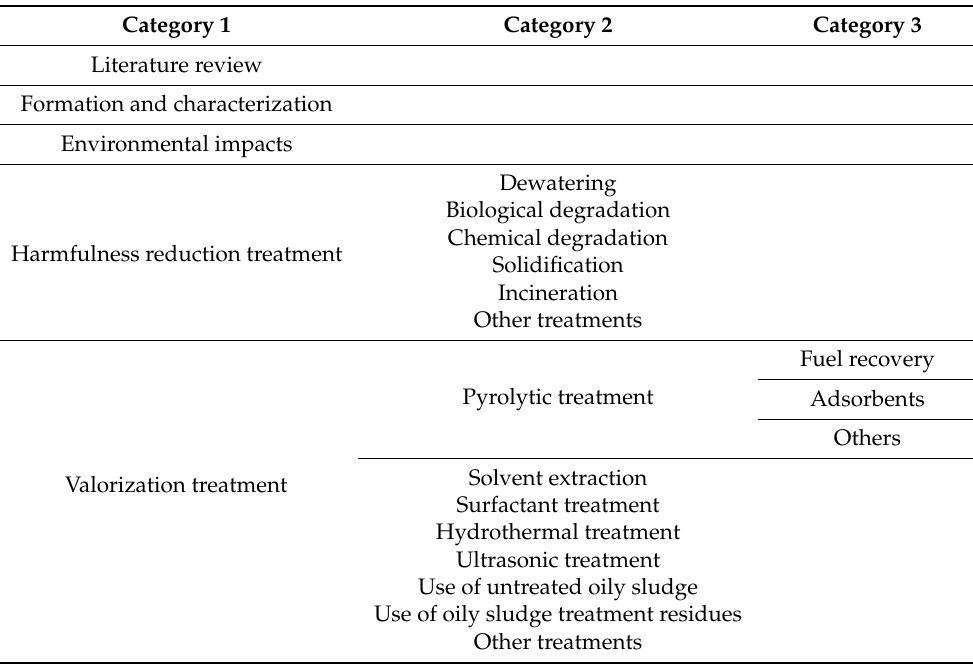
Table 4. The classification system of the oily sludge-related journal articles was retrieved from the Web of Science